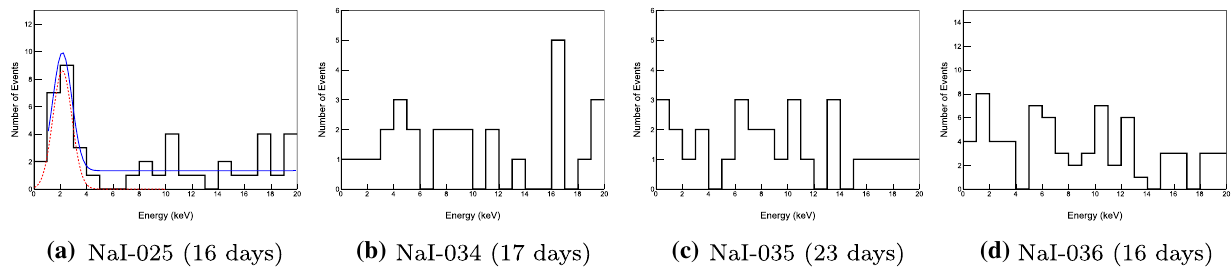
dotted line) with a flat background. However, there is no evidence for the 3.2 keV line in NaI-034 ( b ) and NaI-035 ( c ) and NaI036 ( d ). The exposure time for each crystal is denoted in parentheses